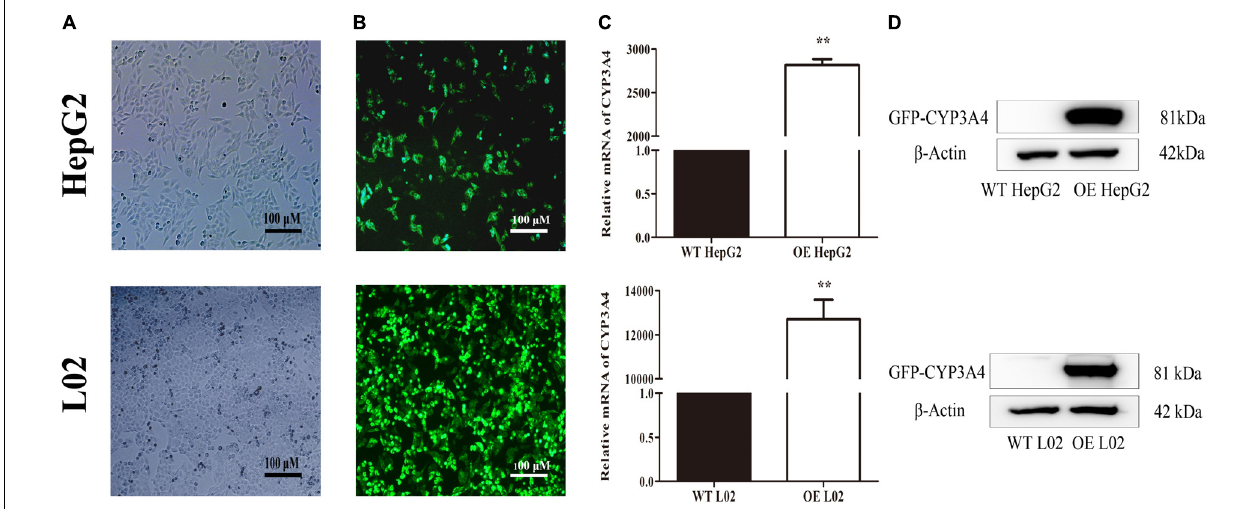
FIGURE 5 | Characterization of wild type (WT) and stable CYP3A4 over-expressed (OE) HepG2 and L02 cells through (A) monitoring under white light, (B) monitoring under fluorescent light, (C) PCR and (D) Western blot. β -actin served as loading control (Original magnification 100 × ; the scale bar is 100 µ m). ∗∗ p < 0.01 vs. WT cells.